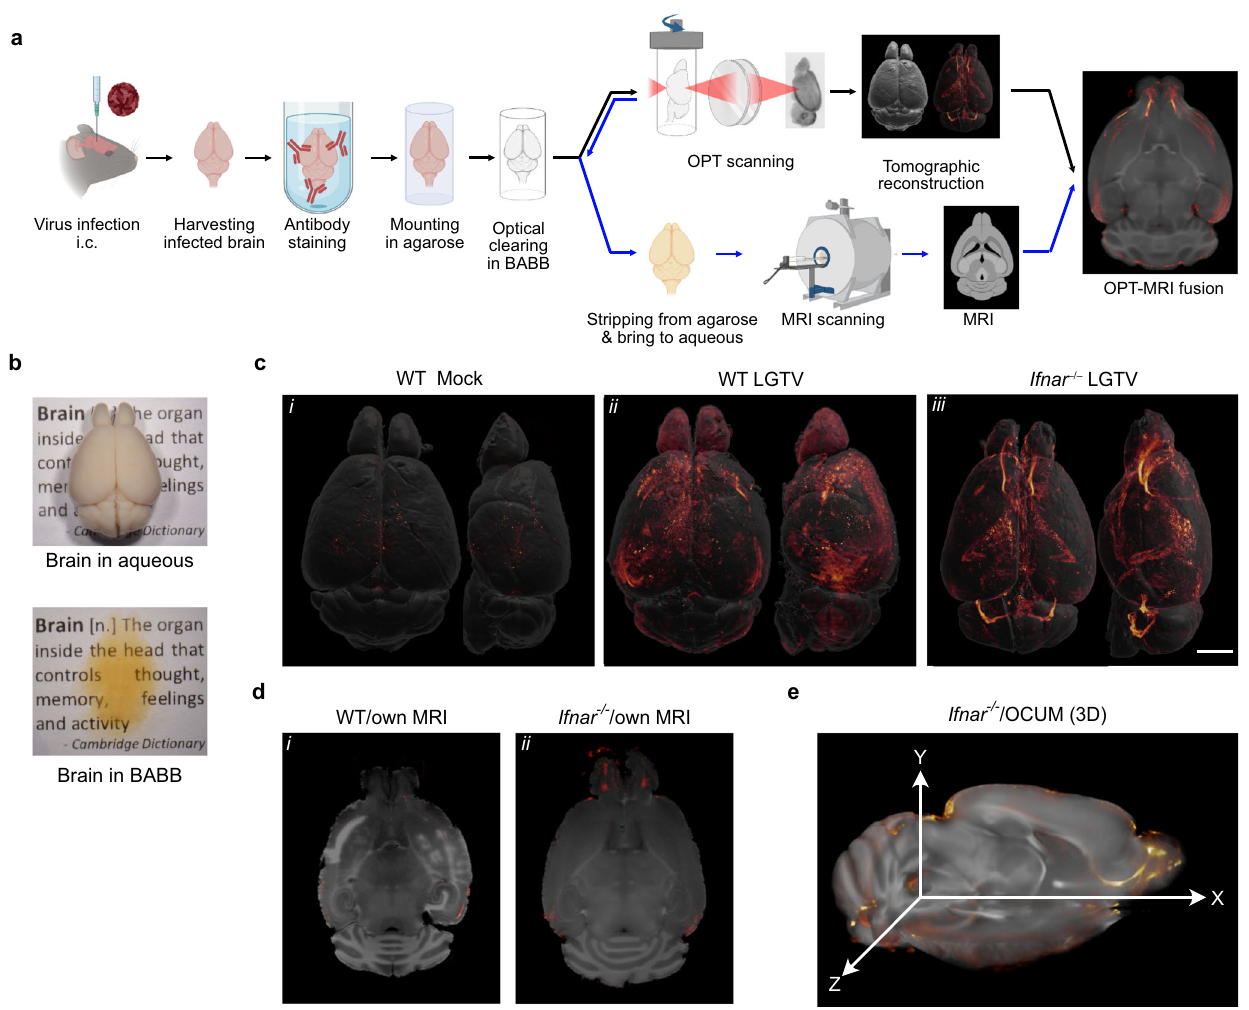
Fig.1 |Wholebrain3Dimagingofviralinfection.a Awork fl owforviralinfection and whole brain imaging. Illustration was created using BioRender.com. b Mouse brainappearanceinaqueousandinopticalclearingsolvent,BABB. c Volumetric3D- renderofthebrainofmockandLGTVinfectedbrainsimmunolabeledwithanti-NS5 antibody (virus marker; red glow). The signal intensity was normalized within an individualbrainand adjustedto identicalminimum and maximum.Foreachimage